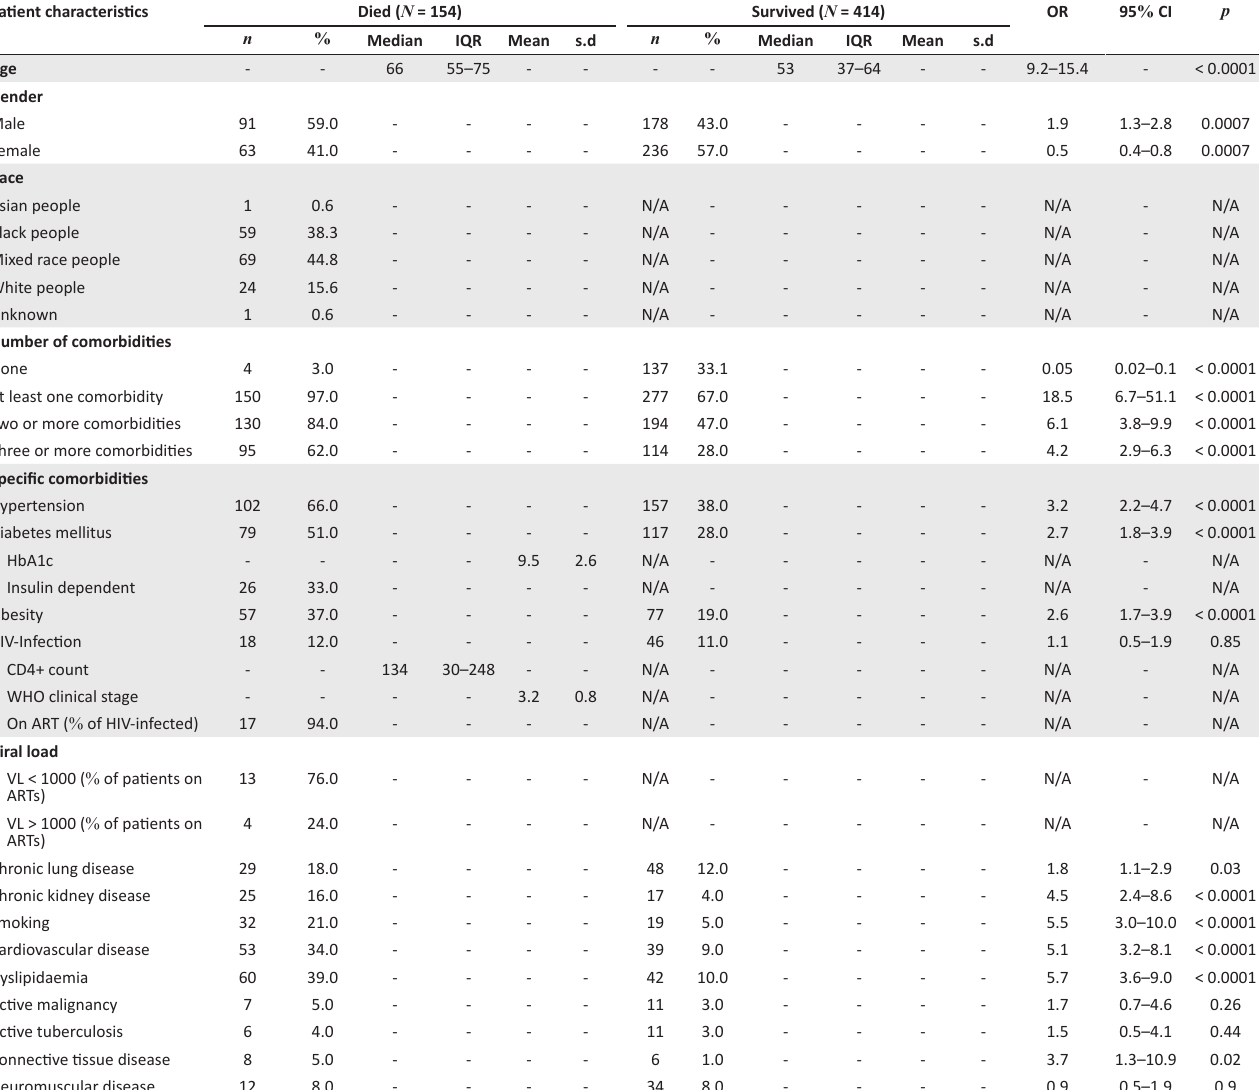
TABLE 1: Comparison of comorbid conditions in patients who died of COVID-19 and those who were discharged alive (survivors). Patient characteristics